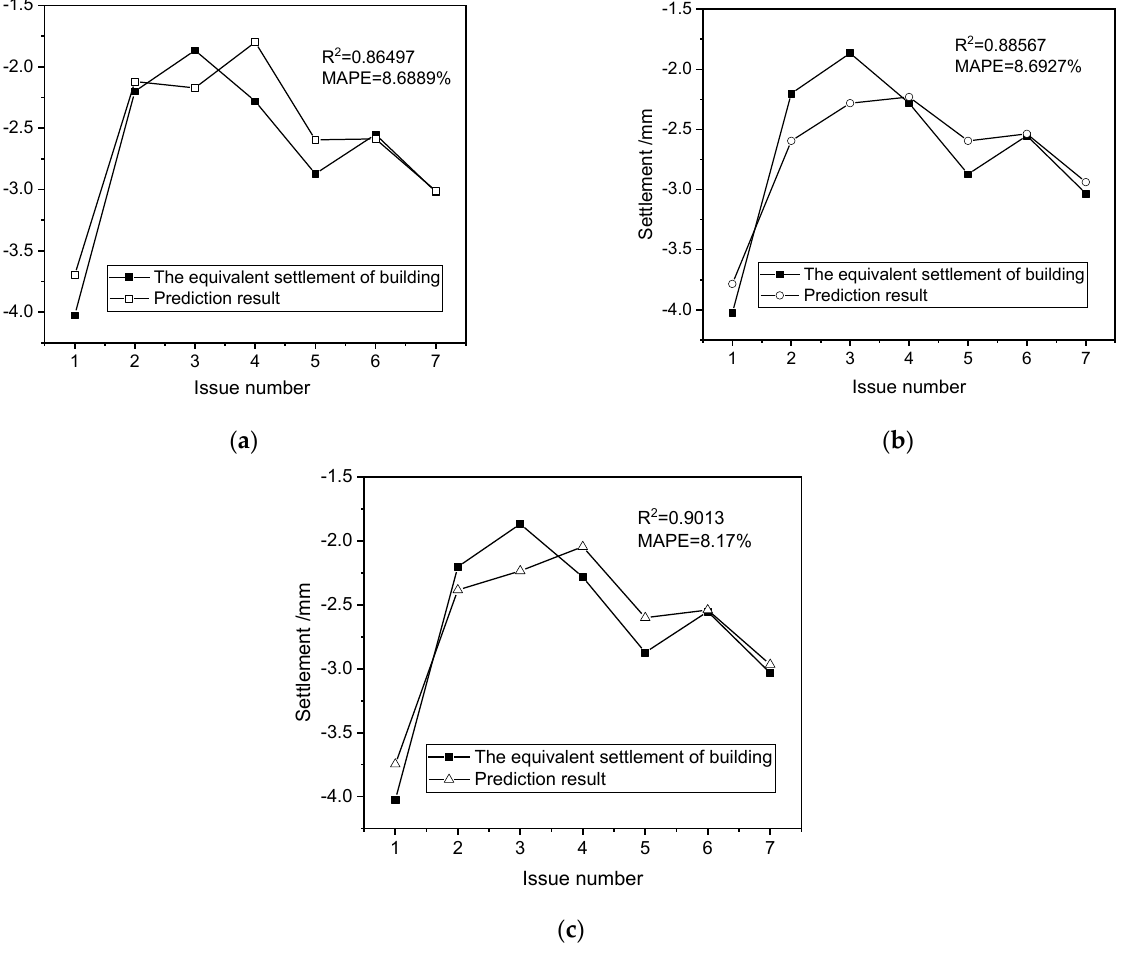
Figure 9. The settlement of buildings predicted by a machine-learning-based model; ( a ) SVM model; ( b ) BP model; ( c ) BP–SVM model.